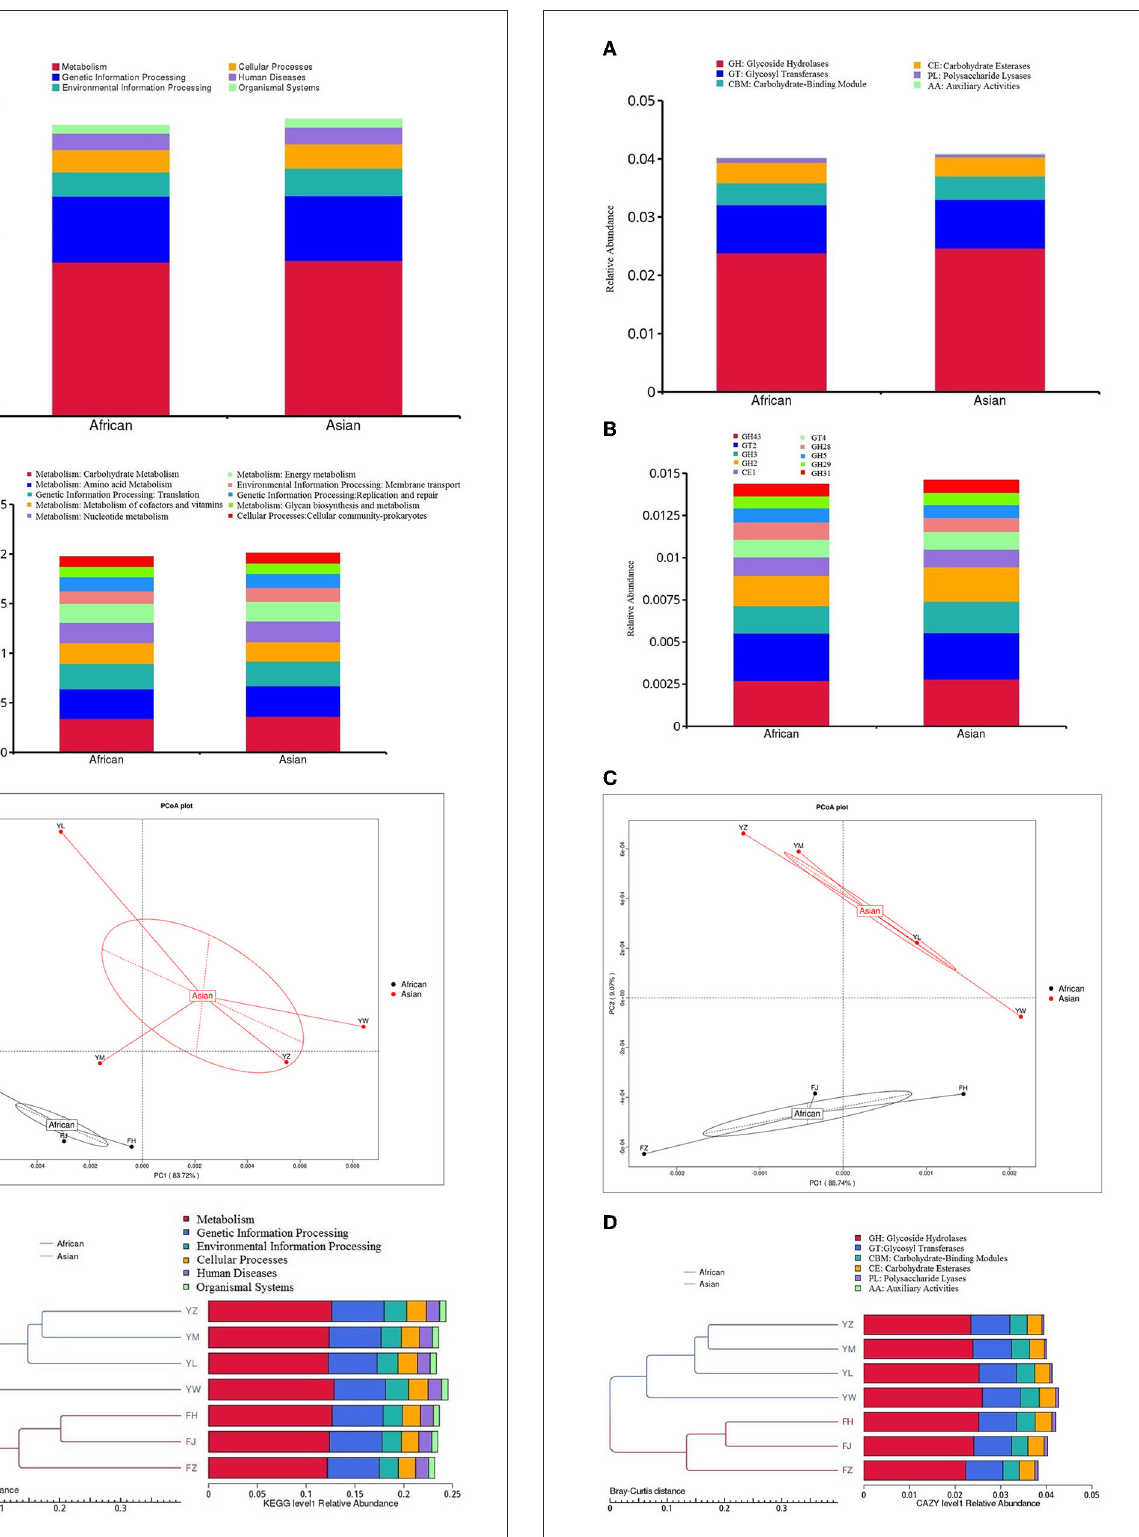
FIGURE6 (A) Relative gene abundance bar plot of functional annotations at level 1 in CAZy database; (B) Relative gene abundance histogram of top ten functional annotations at level 2 in CAZy database in African ( n = 3) and Asian ( n = 4) elephants. (C) PCoA analysis of functional gene abundance at level 1 in CAZy database based on Bray-Curtis distance. (D) Clustering tree based on Bray-Curtis distance (the left side is the clustering tree structure; the right side is the functional relative abundance distribution of each sample at the first level of